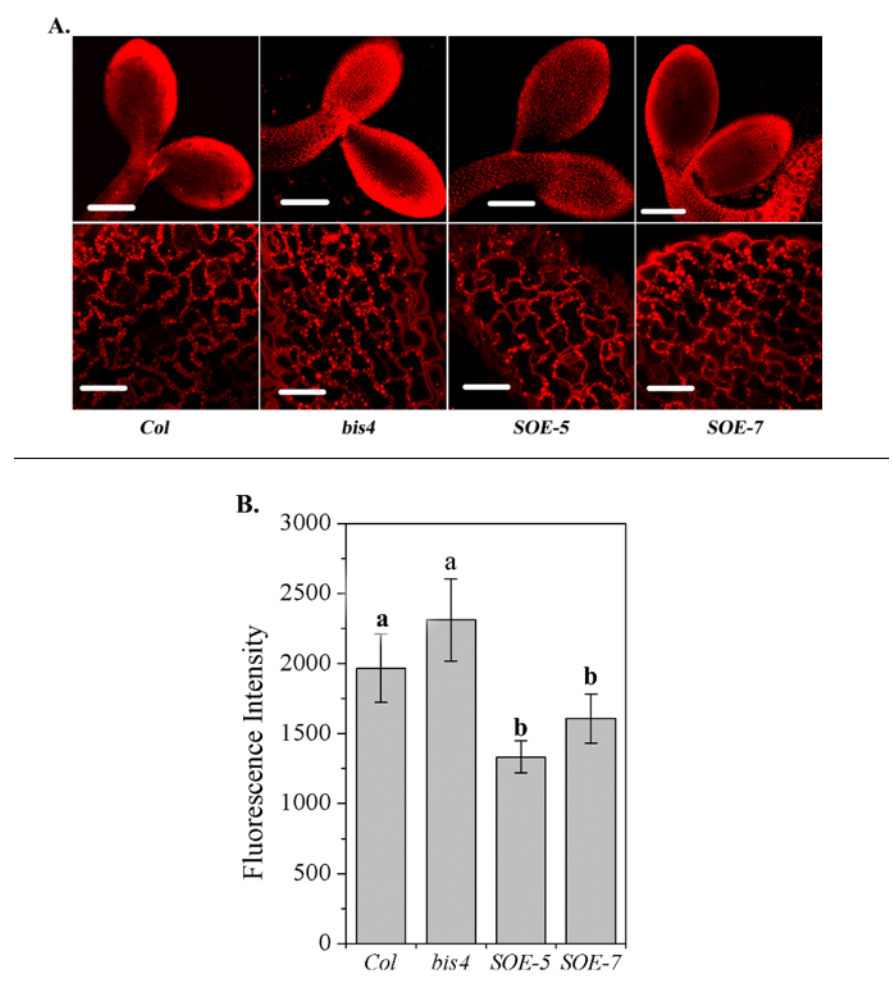
Figure 2. Level of total lipid accumulation in the cotyledonary leaves of Col, bis4 , SOE-5, and SOE-7 plants. ( A ) Representative images of lipid accumulation in 2-d-old cotyledonary leaves of Col , bis4 mutant, SOE- 5, and SOE-7 plants after staining the seedlings with Nile red. The top panel images were captured at 10 × magnification with an Olympus FV 1000 system. Bars = 200 µm; the bottom panel images were captured at 60 × magnification with an Olympus FV 1000 system. Bars = 30 µm. ( B ) Fluorescence intensity. The average fluorescence intensity of the whole cotyledon was calculated. The higher the fluorescence intensity, the higher the total lipid content.